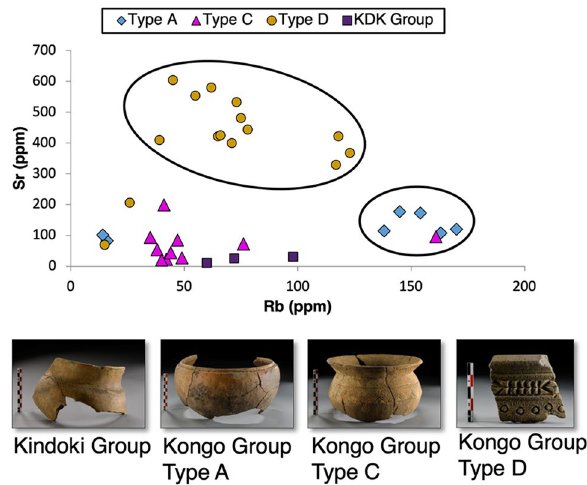
Figure 7. XRF data. Scatter plot Rb–Sr, selected samples from Kongo kingdom pots, colour-coded by typological group. Plot indicating the correlation between Kongo Type D pots and strontium and between Kongo Type A pots and rubidium.